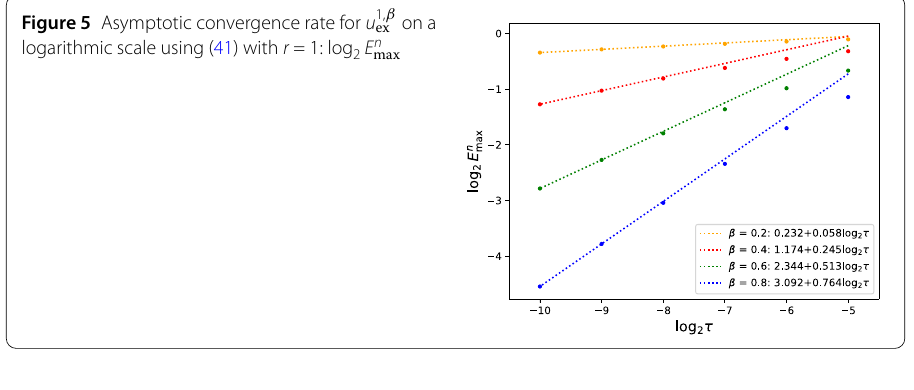
Figure 5 Asymptotic convergence rate for u 1, β ex on a logarithmic scale using (41) with r = 1: log 2 E n max